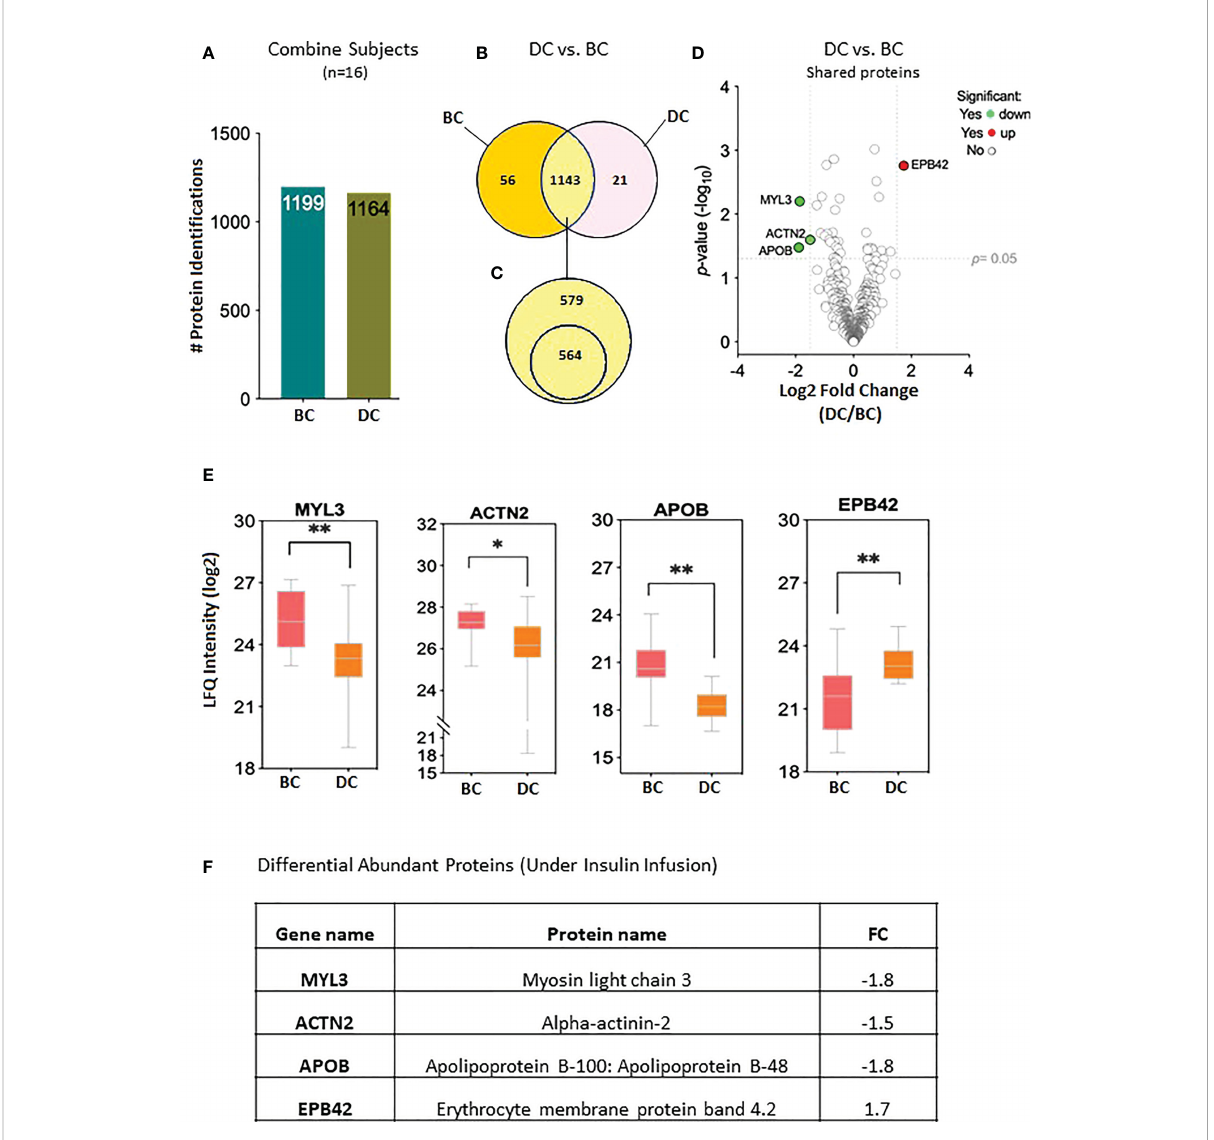
FIGURE 2 Proteins levels at the baseline and at 2 hours of insulin infusion in the 16 subjects. (A) Bar chart representing the number of proteins identi fi ed in each condition. (B) Venn diagram showing the unique and common proteins in response to clamp. (C) Proteins sorted for their presence in at least half of the subjects. (D) Volcano plot showing the differential abundance of proteins in response to insulin infusion. (E) Box plots representing the proteins with signi fi cant differential abundance. *p=0.02, **p=0.001. BC: Before Clamp (basal values); DC: During Clamp (insulin infusion for 2 hours). (F) Fold changes in the proteins signi fi cantly increased during insulin stimulation versus